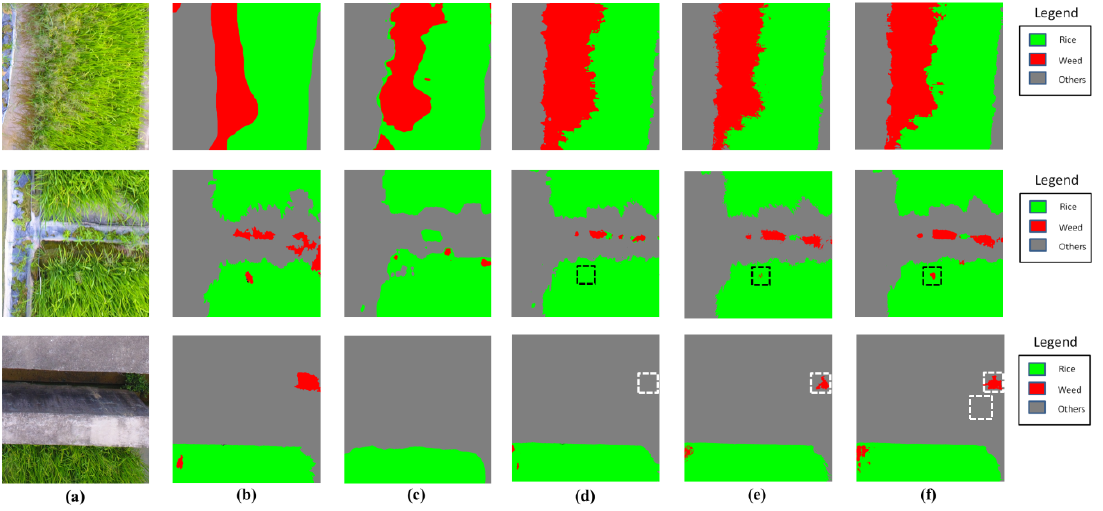
Figure 12. The classification results obtained by methods in comparison. ( a ) aerial images; ( b ) corresponding GT labels; ( c ) output by Pixel-based-SVM; ( d ) output by FCN-8s; ( e ) output by ASPP-1 without CRFs; ( f ) output by ASPP-1 with CRFs.